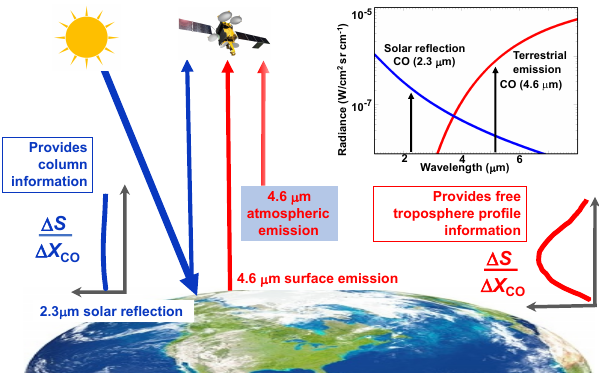
5 Characterization of CHRONOS CO and CH 4